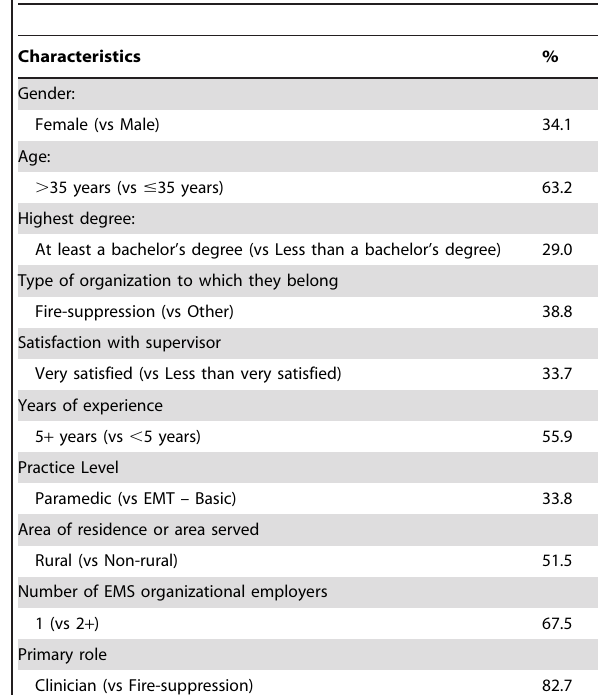
Table 1. Characteristics of EMS clinical service providers